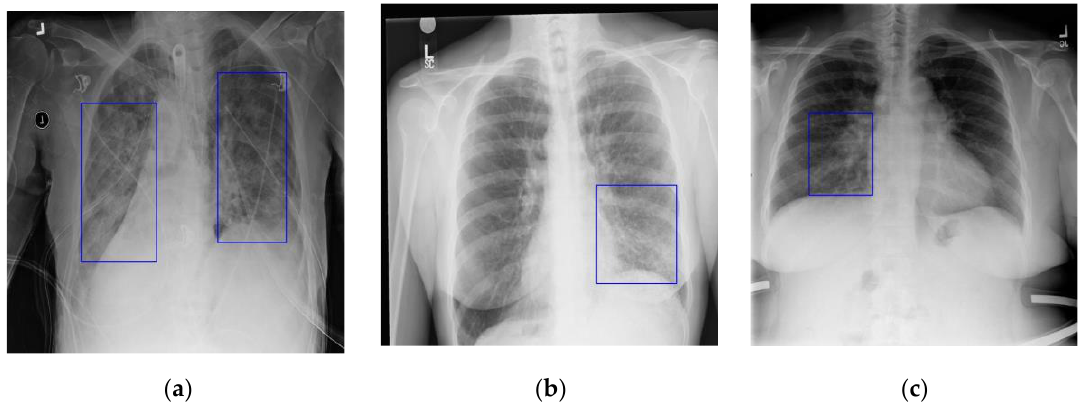
Figure 2. Experimental data used in this study. The area within the blue box shows a pneumonia lesion. In images ( a ) and ( b ), there is no significant difference between pneumonia lesion and non- lesion. It can be seen from image ( c ) that the features of the left lesion and the right non-lesion are